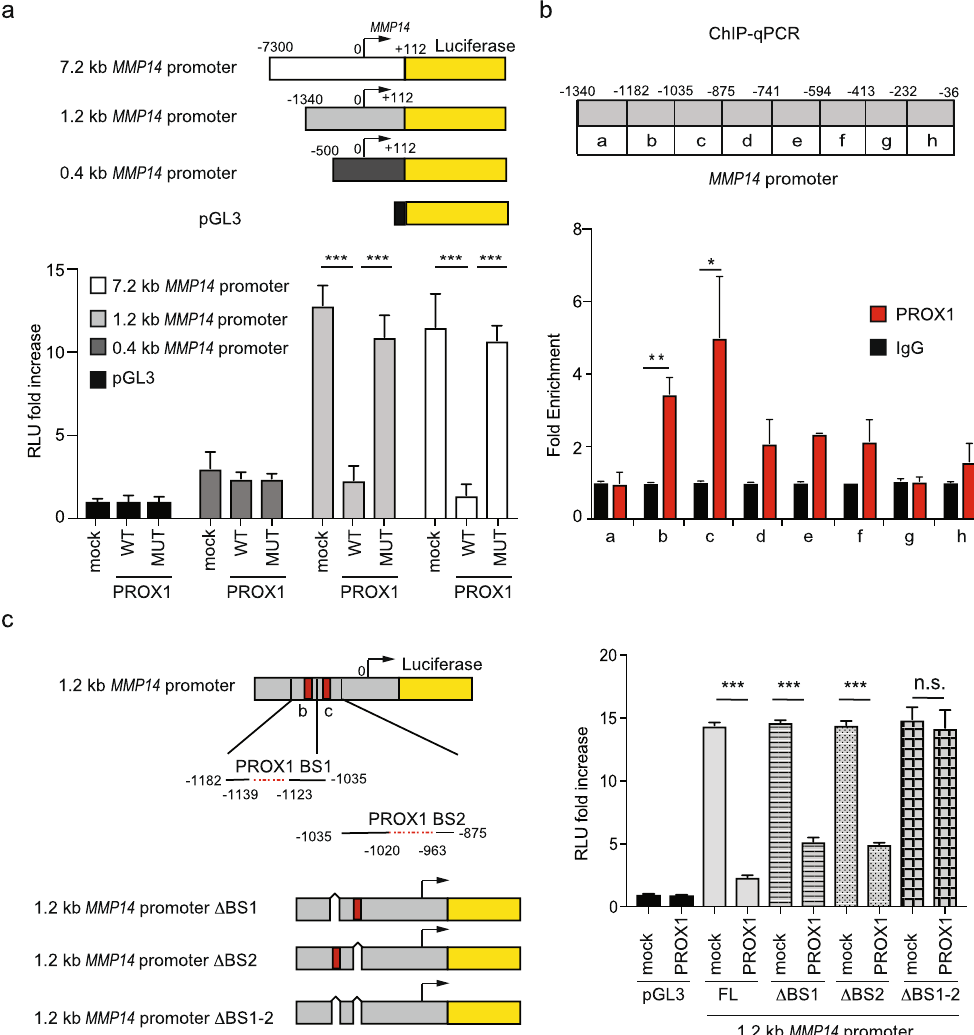
Figure 2. PROX1 binds to the MMP14 promoter and regulates its expression. ( a ) Upper panel: schematic diagram of the MMP14 promoter fragments, numbers indicate the bp upstream ( − ) or downstream ( + ) of the MMP14 transcription start site (TSS, where bp = 0 is MMP14 TSS), indicated by the black arrow. Bottom panel: luciferase reporter assay using either the pGL3 backbone or its indicated derivatives depicted above. HeLa cells were co- transfected with the indicated reporter plasmids (0.1 µ g) and expression vectors for PROX1 WT or MUT (1 µ g) in duplicates. An empty pAMC vector was used as a control (mock). 32 h after transfection, cell extracts were collected and luciferase activities were measured. The graph includes the data from three independent experiments. Error bars represent SD. (b) Upper panel: schematic representation of the MMP14 promoter region spanning from bp − 1340 to − 36. Letters denote the fragments amplified by different sets of primers (a–h) used in the ChIP-qPCR below. Bottom panel: Chromatin immunoprecipitation using either PROX1 or control IgG antibodies followed by qPCR with primers amplifying the indicated regions of the 1.2 kb MMP14 promoter region. Average fold enrichment over the IgG is shown for three independent experiments; error bars represent SD. ( c ) Left: schematic representation of the 1.2 kb MMP14 promoter reporter plasmid, the b and c regions immunoprecipitated in ( b ) are marked as red boxes. PROX1 binding site containing regions (BS1 and BS2) are illustrated below as red dotted lines, numbers indicate their position upstream of the MMP14 TSS. These sequences were deleted in the 1.2 kb MMP14 promoter reporter plasmid (white boxes), generating the 1.2 kb MMP14 promoter mutants Δ BS1, Δ BS2, Δ BS1-2. Right: Luciferase assay performed as in ( a ) using 1.2 kb MMP14 promoter either full length (FL) or the indicated mutants co-transfected with either a pAMC control vector (mock) or a PROX1 WT expression vector. * p < 0.05; ** p > 0.01; *** p >